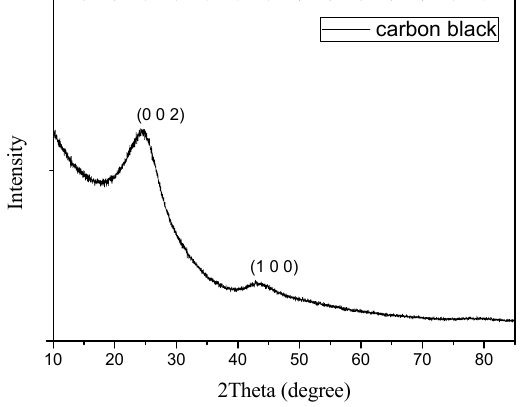
Figure 5. The XRD curve of carbon black.